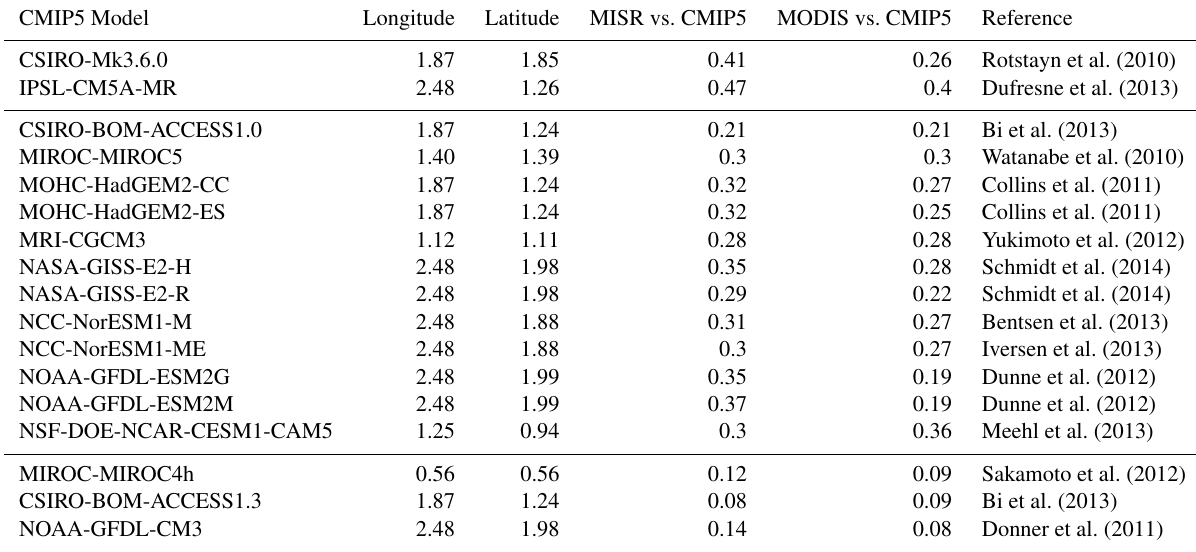
Table 2. The CMIP5 models examined in this study along with their grid resolutions. The correlation coefficients of the comparison of model- derived AOD with MODIS and MISR AODs are also given. The various models are segregated into three groups based on the performance of their correlation with MISR AOD. Details are given in the